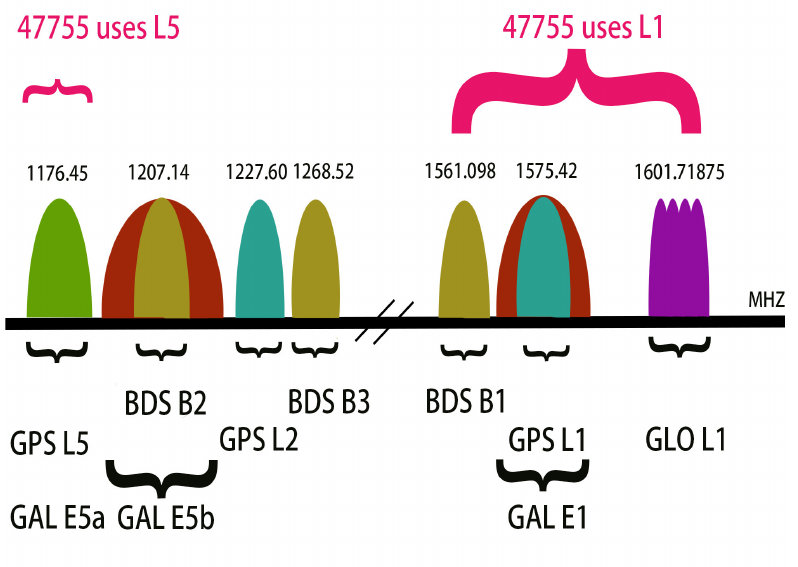
Figure 2. Visualization of the various GNSS carrier